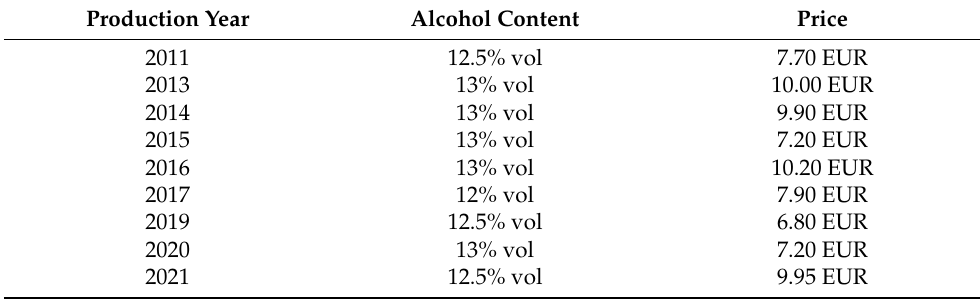
Table 1. Sample details declared by the production